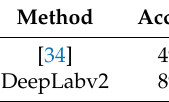
Figure 11. Examples of balloon segmentation from: DeepLabv2 ( top-left ); [34] ( top-right ); mixed ( bottom-left ); and over the original image ( bottom-right ). The white pixels represent the pixels labeled as part of a balloon. In the mixed ( bottom-left ) result, we can see that CNN model indicates better the true positives examples while the traditional method gives the shape of the balloons. Table 11. The accuracies of balloon segmentation on comic pages, on the eBDtheque testing